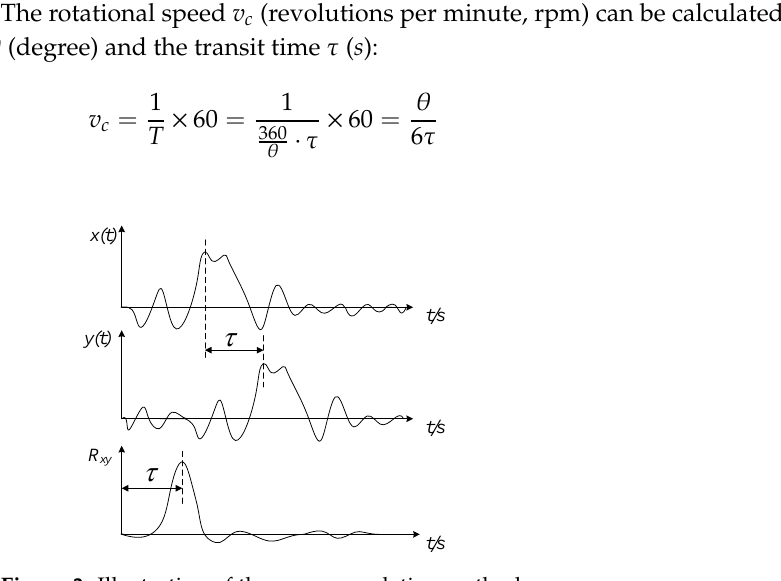
Figure 3. Illustration of the cross-correlation method.